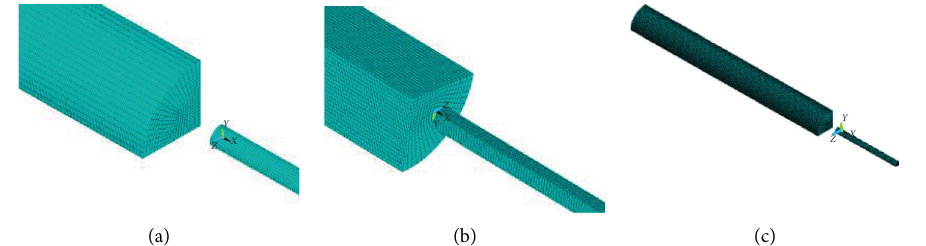
Figure 2: The calculation model of penetration.